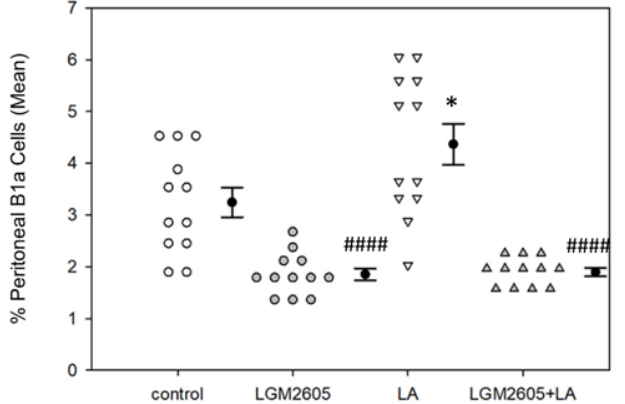
Figure 4. Detection of peritoneal B1a B cells by flow cytometry. LA treatment significantly increased the percentage of peritoneal B1a B cells compared to saline control, * p = 0.017. LGM2605 treatment, either alone or combined with LA, significantly reduced the percentage of peritoneal B1a B cells compared to both LA only (#### p < 0.0001) and saline control (#### p < 0.01). Following two-way ANOVA, data were analyzed via Tukey post-hoc test. No sex effects were observed.